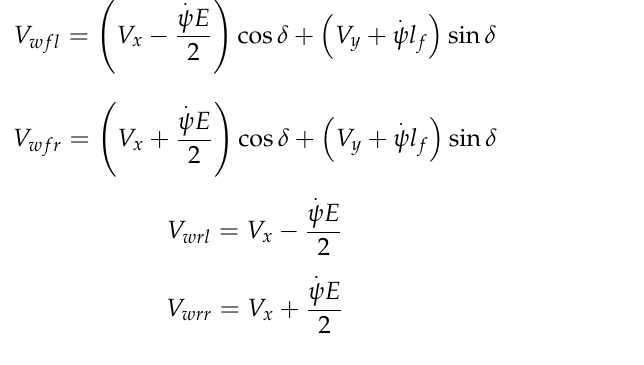
Figure 5. Static and dynamic wheel radius.